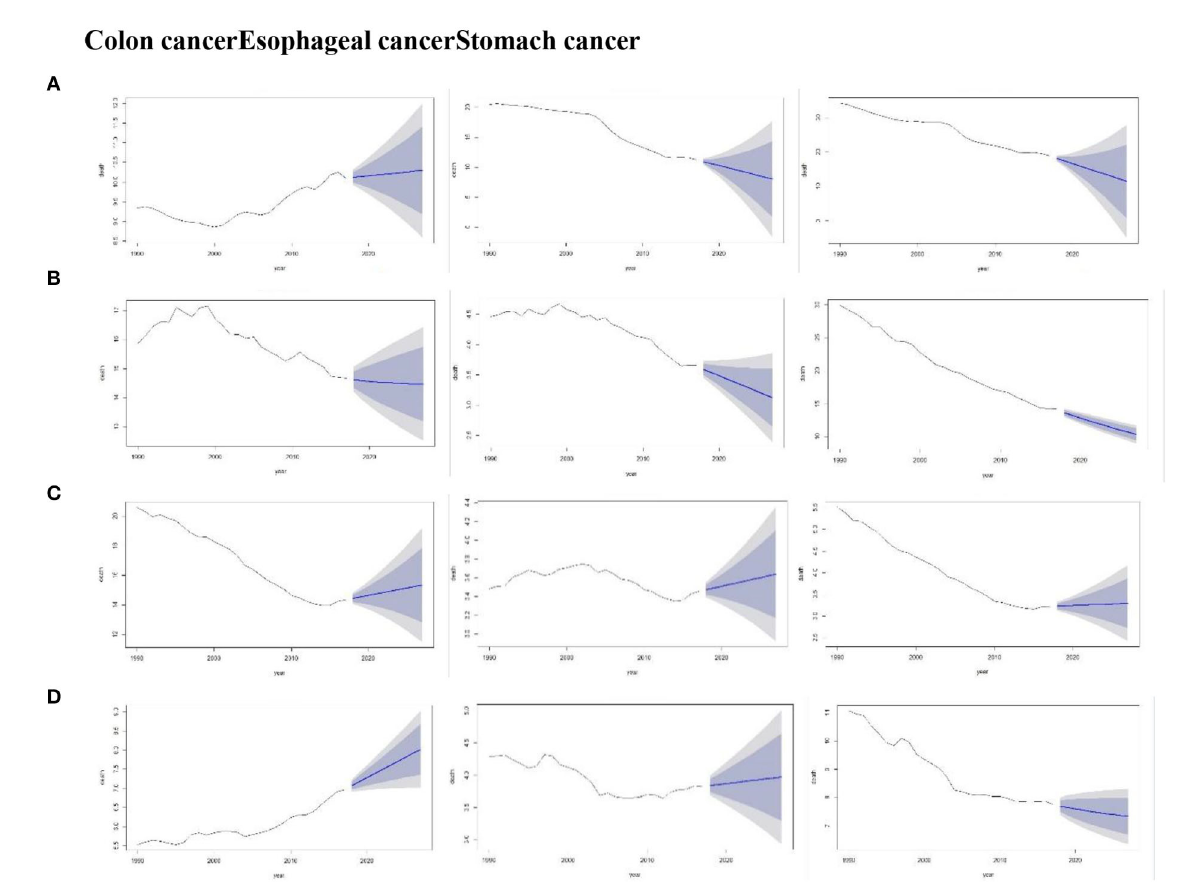
FIGURE5 Forecast of the death rate using the Holt model for the period, 1990–2027 (Colon cancer, Esophageal cancer, and Stomach cancer) by China (A) , Japan (B) , the US (C), and India (D) . Shades represent 80 and 95% prediction